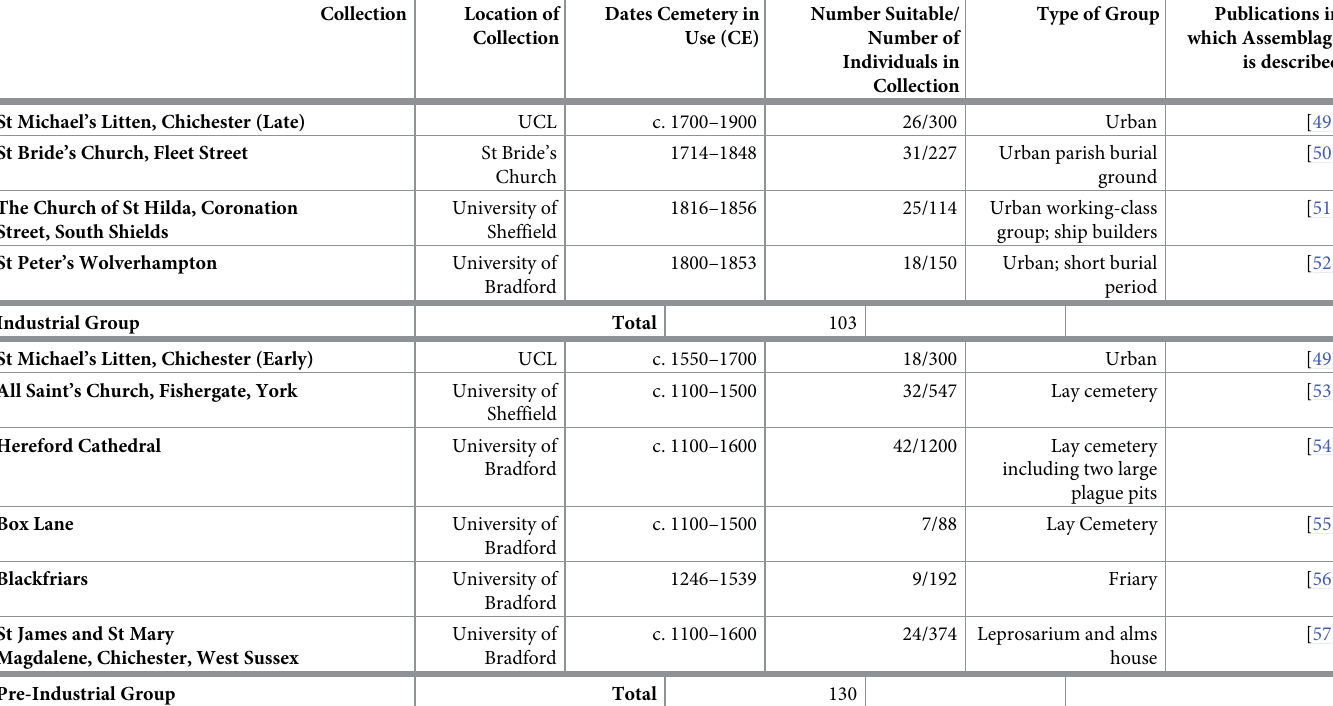
Table 1. Table showing the assemblages included in the current study and giving details of their locations, size, date and the number of individuals from this collec- tion that satisfied the inclusion criteria. Individuals from cemeteries dating from 1100–1700 CE formed the pre-industrial group and those from cemeteries dating from 1700–1900 CE formed the industrial